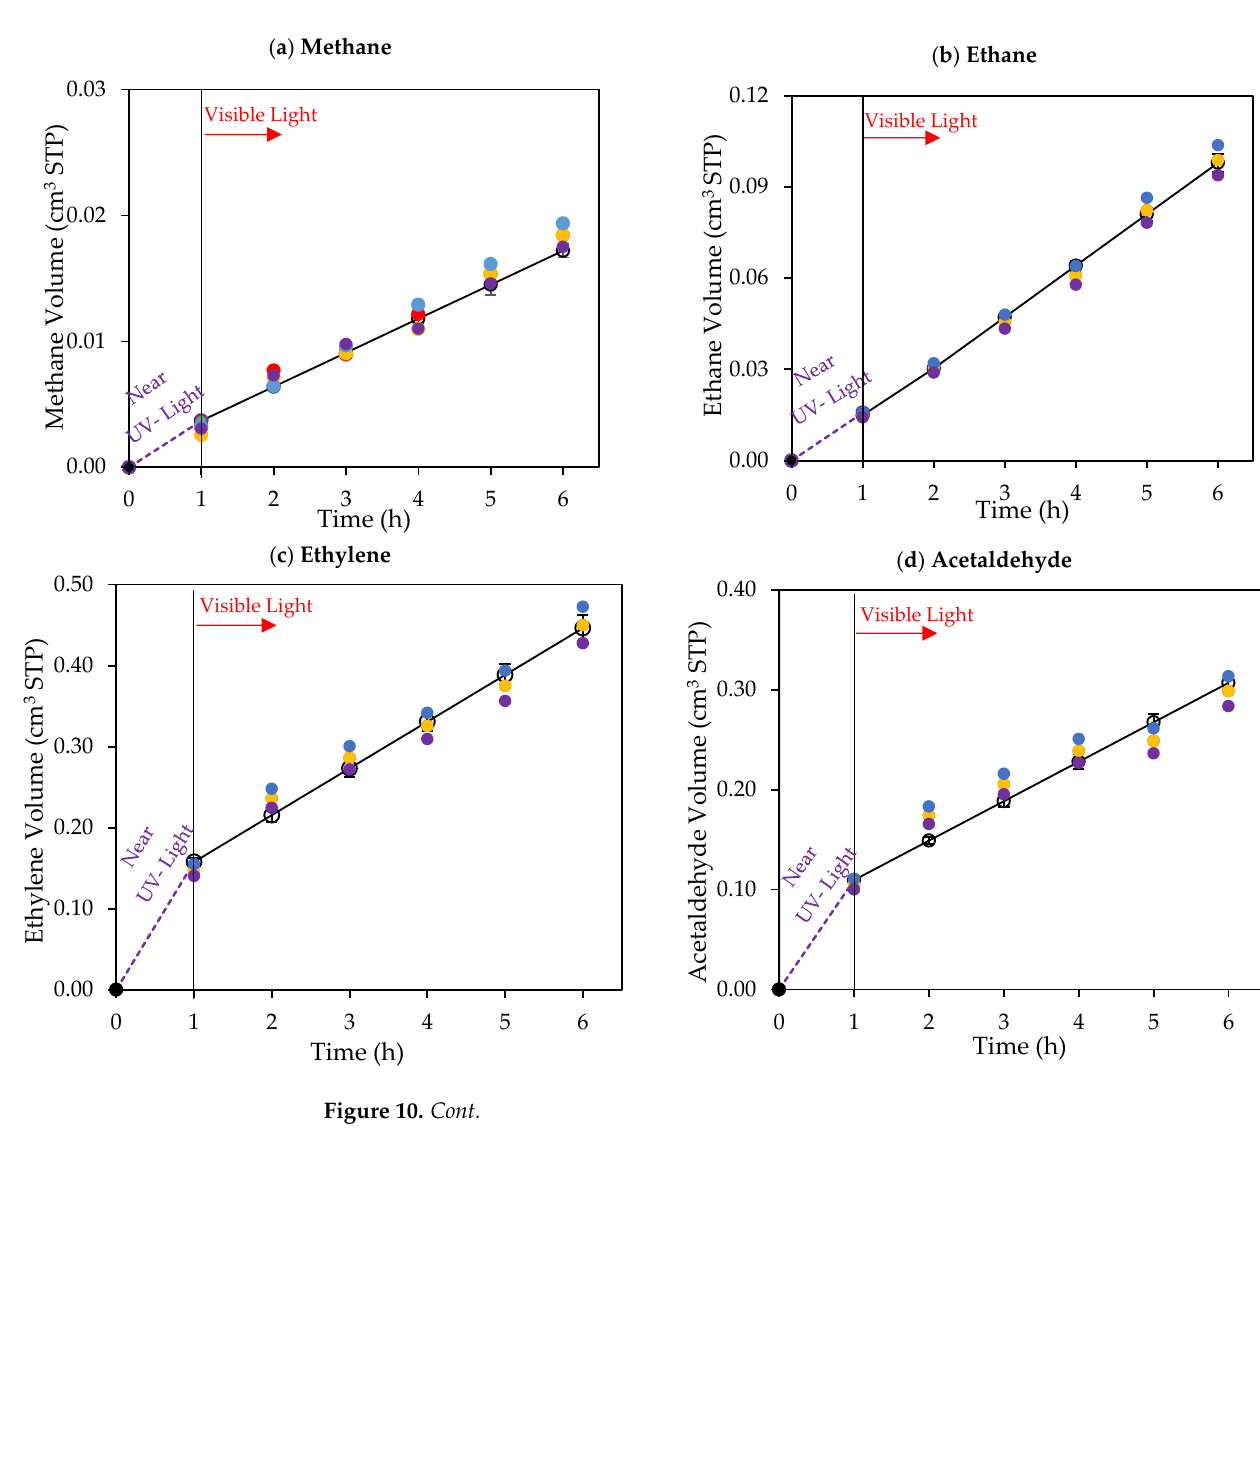
hydrogen volumes: 0 to 113 cm 3 STP; ( b ) CO 2 , CH 4 , C 2 H 4 O, C 2 H 6 and C 2 H 4 volumes, 0 to 1.8 cm 3 ;